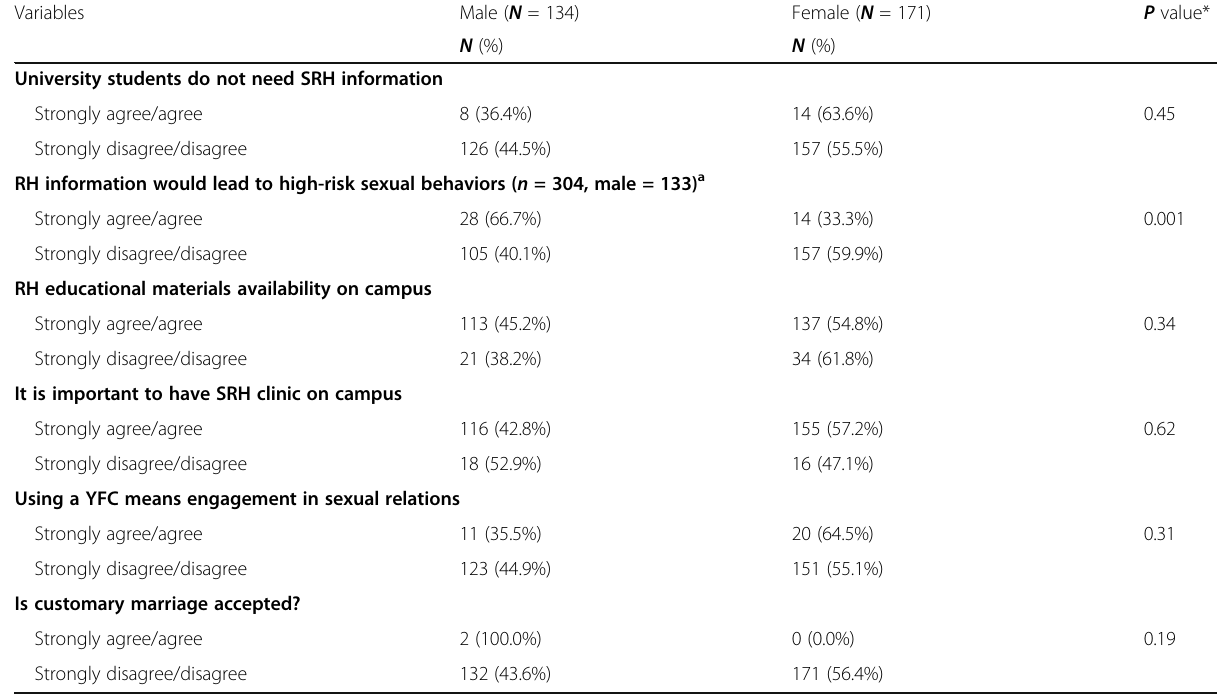
Table 5 Distribution of the university student ’ s attitude towards reproductive health issues and YFC by gender